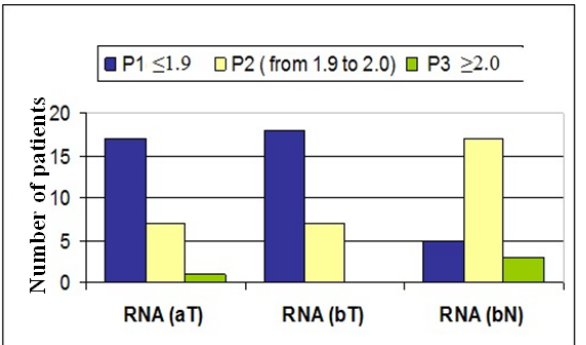
) measurements. 260/280